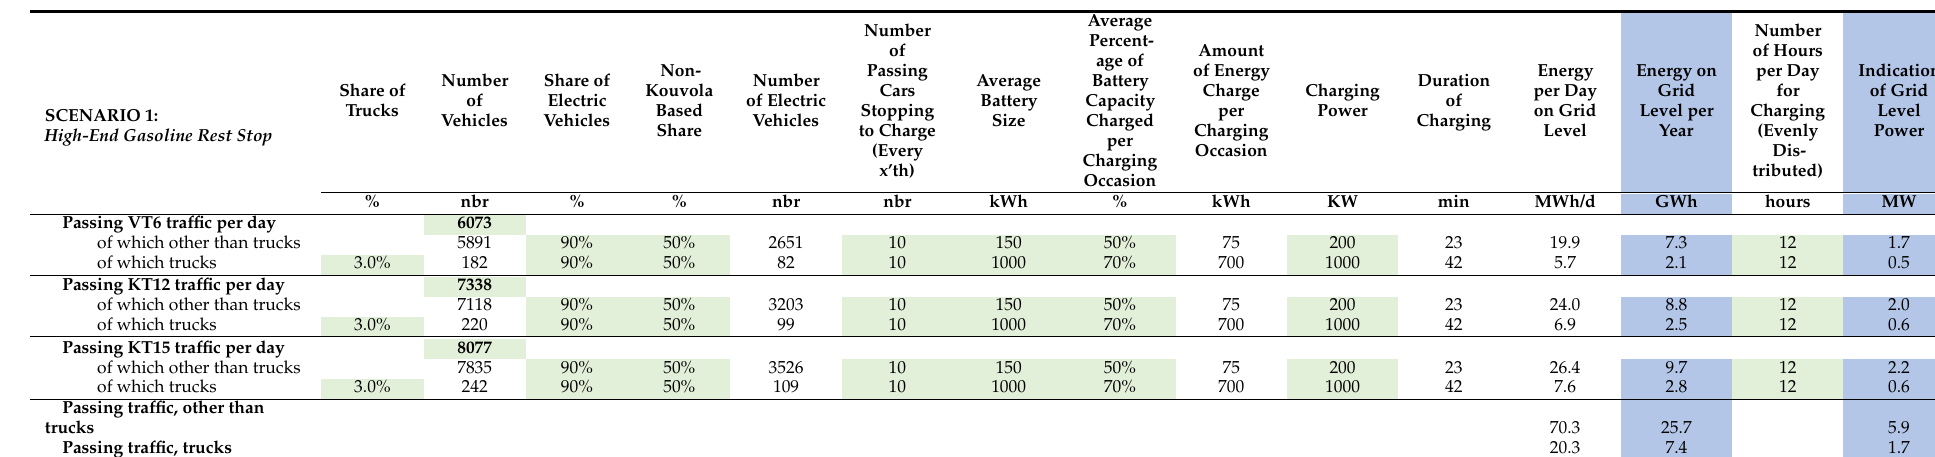
Table A3. Detailed quantification of passing traffic (the derived additional energy is consolidated into the summary (Table A1) and subdivided into user groups in Table